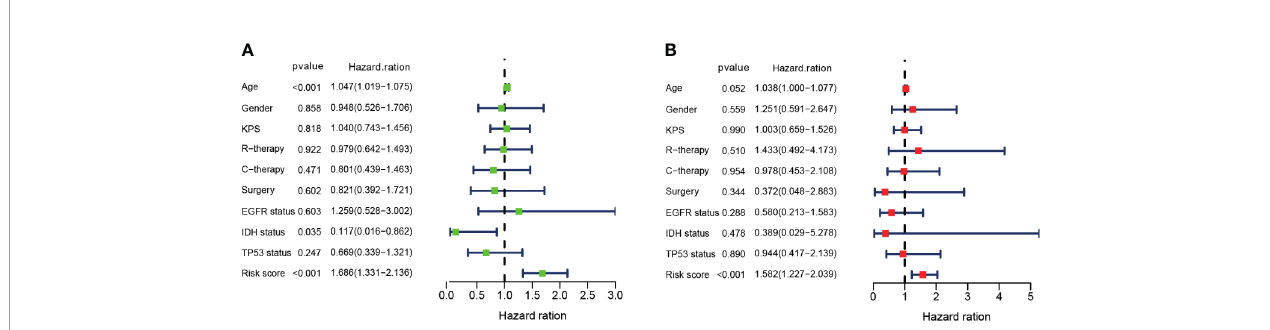
FIGURE 5 | DMDG prognostic model is an independent prognostic factor. (A) Univariate analysis of the risk score and other clinical information in TCGA GBM cohort. (B) Multivariate analysis of the risk score and other clinical information in TCGA GBM cohort. KPS, Karnofsky Performance Status; R-therapy, radiotherapy; C-therapy, chemotherapy; EGFR, Epidermal Growth Factor Receptor; IDH, isocitrate